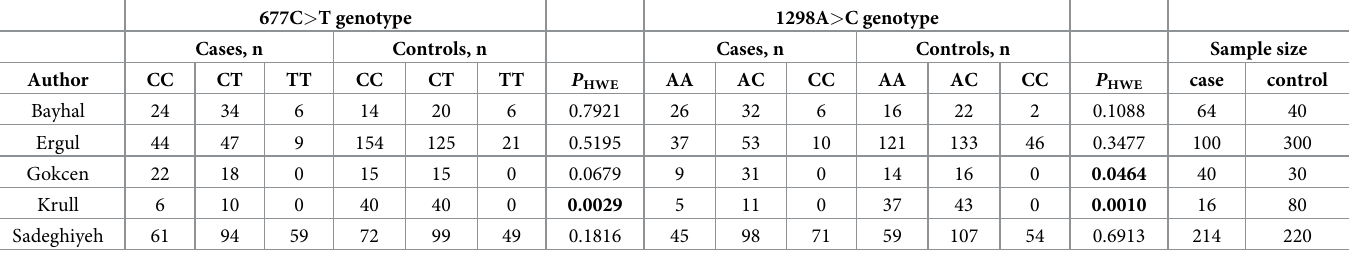
Table 5 and Fig 2 show results generated for five genetic models evaluating the association between 667C > T variation and ADHD risk under a random effects model. Results indicated no association between 677C > T locus and ADHD occurrence. Table 2. Distribution of genotype and allele frequencies of the MTHFR 677C > T and 1298A > C polymorphisms in ADHD